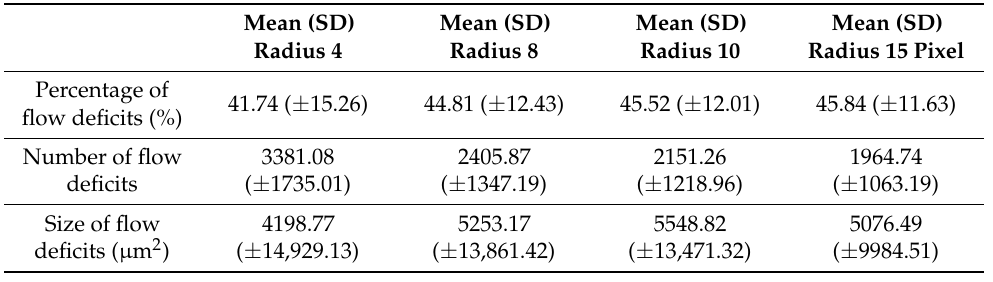
Table 5. Choriocapillaris abnormalities in the non-neovascular group according to radii ( n =